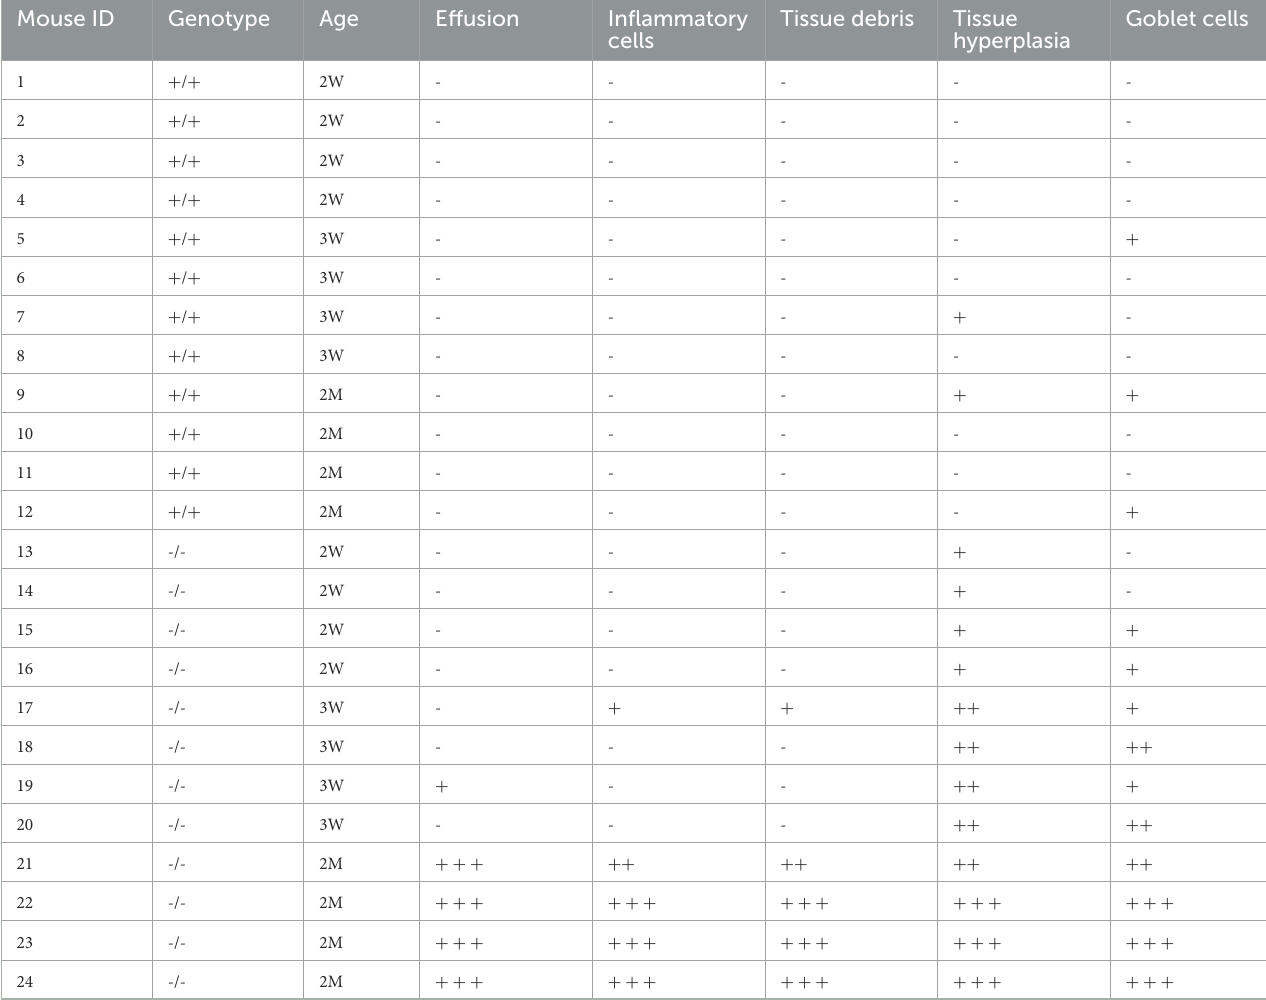
TABLE 1 Semi-quantitative evaluation of the middle ear pathology in mutant mice. Mouse